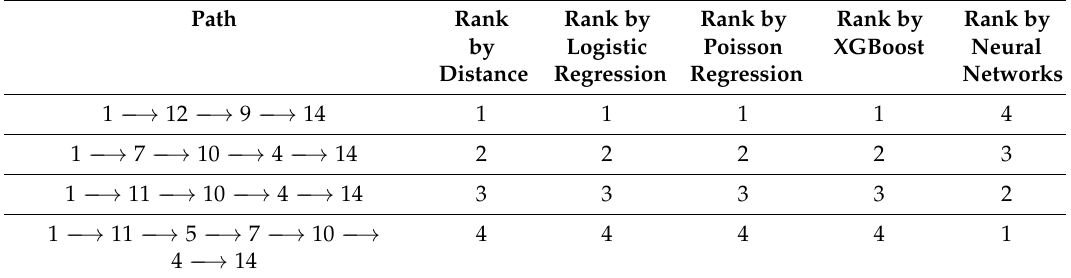
Table 7. Risk ranking for the k = 4 shortest paths using the four predictive models. Path Rank